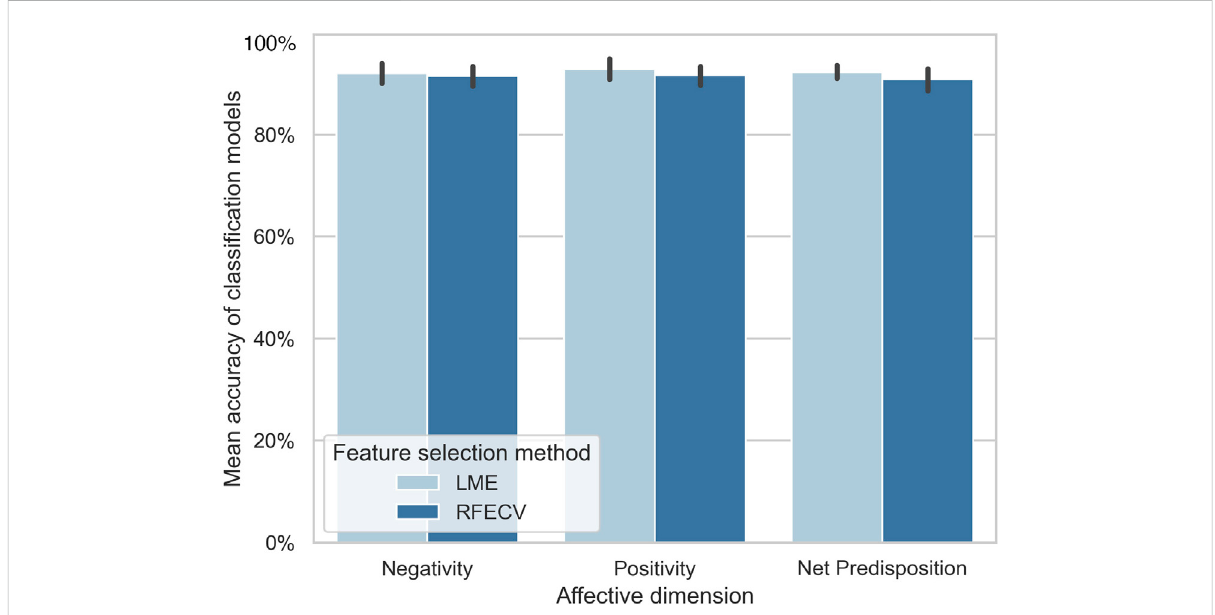
FIGURE 4 Mean accuracy of the classi fi cation models for each affective dimension of the ESM (Cacioppo et al., 1997). The accuracy of the classi fi cation models trained with features selected using LME was not statistically signi fi cantly different than the accuracy of the models trained with features selected using RFECV. The accuracy of the classi fi cation models was similar across affective dimensions. Error bars depict CI,